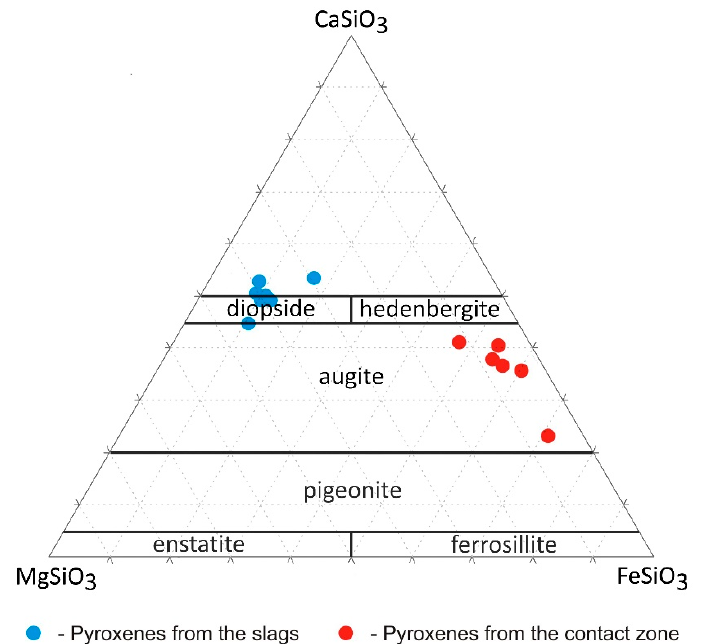
Figure 5. Ternary classification diagram of pyroxenes from the slags and the contact zone (based on Morimoto, 1988 [45]).